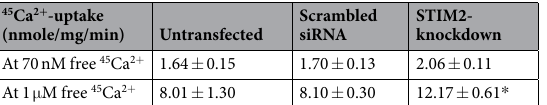
In the present study, we searched for STIM2-binding proteins from among proteins that mediate or regulate skeletal muscle functions, and we examined the functional role of the STIM2-binding protein along with STIM2